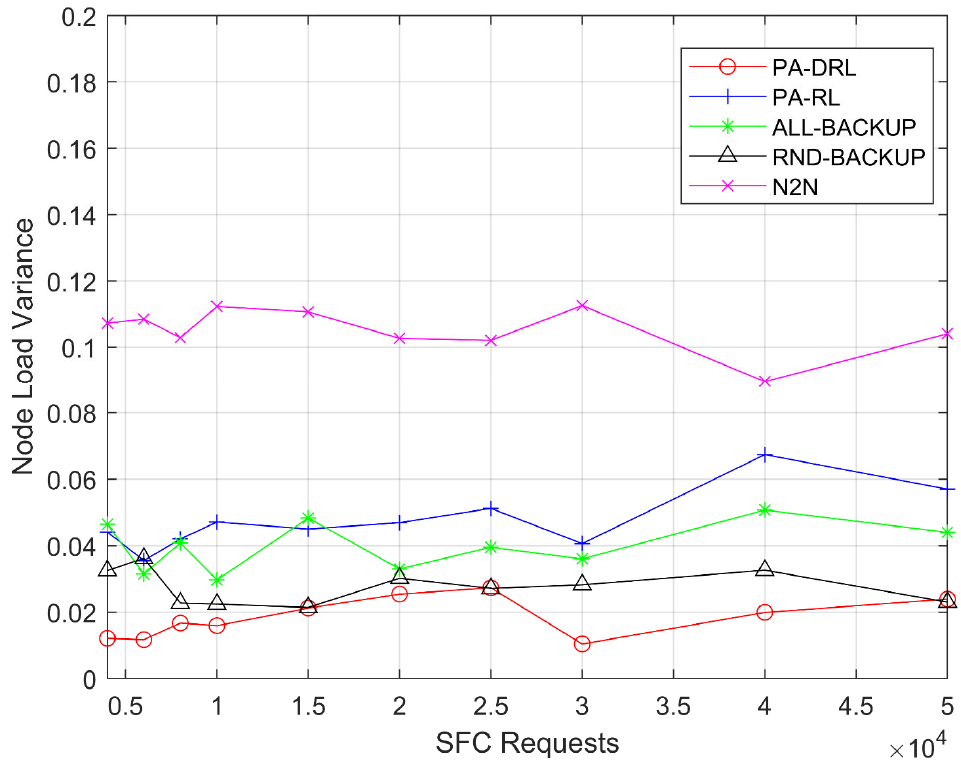
Figure 6. Node load balancing variance under each SFC requests number.